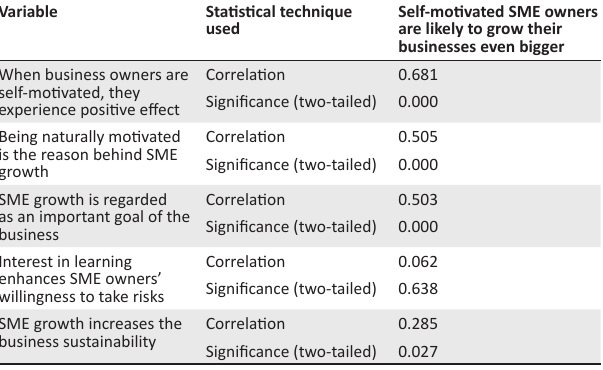
TABLE 4: Correlation tests for self-motivation of business owners for small and medium enterprise growth. Variable